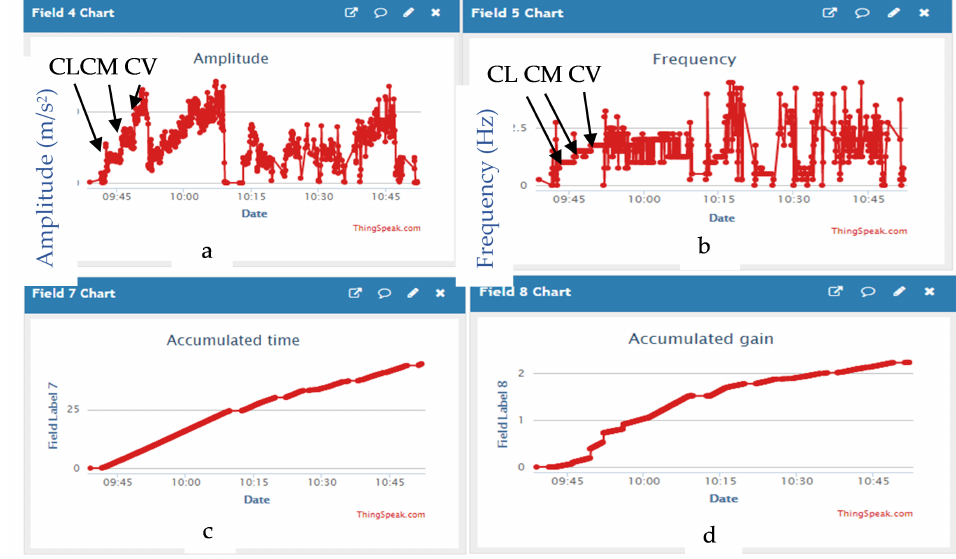
Figure 2. Amplitude and frequency data from different physical activities at different intensities over one hour. ( a ). amplitude of the dominant frequency, ( b ). frequency, ( c ). accumulated time, ( d ). accumulated